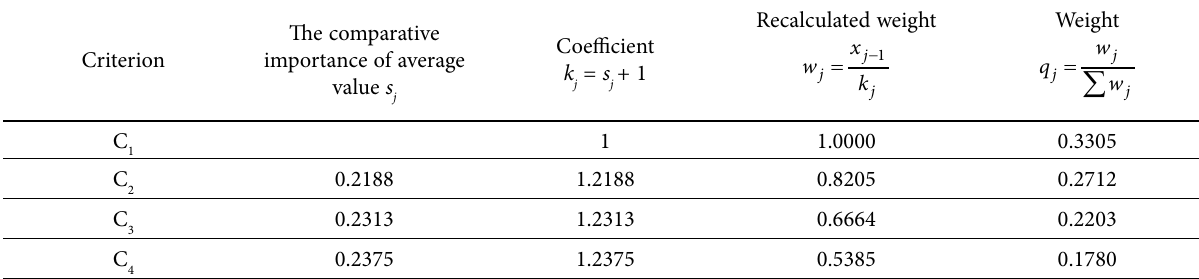
Table 5. Final results of SWARA method in weighting criteria